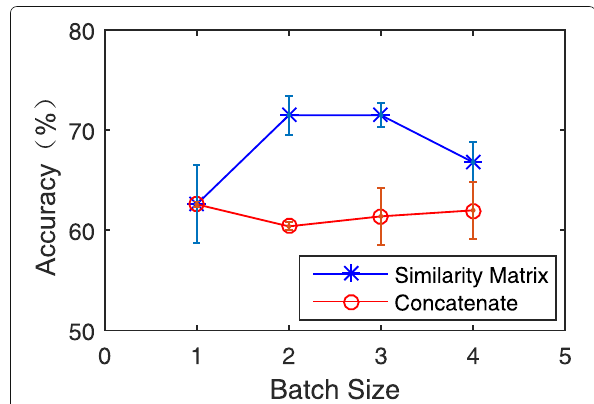
Fig. 6 Model comparison. Comparison results between base model and the model using similarity matrix